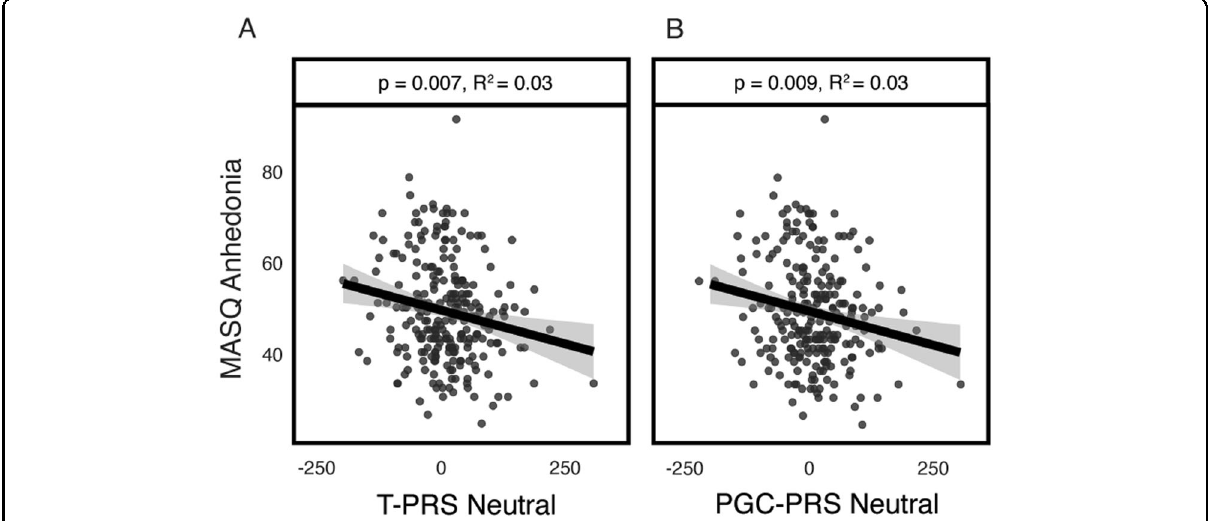
Fig. 3 Brainscores and anhedonia. Greater blunting of the T-PRS LV1 regions was associated with more anhedonia in females ( R 2 = 0.03, p = 0.007; A ). Similar negative relationship was also observed in females between the PGC-PRS-associated blunting of neural response to neutral faces and anhedonia ( R 2 = 0.03, p = 0.009; B ).